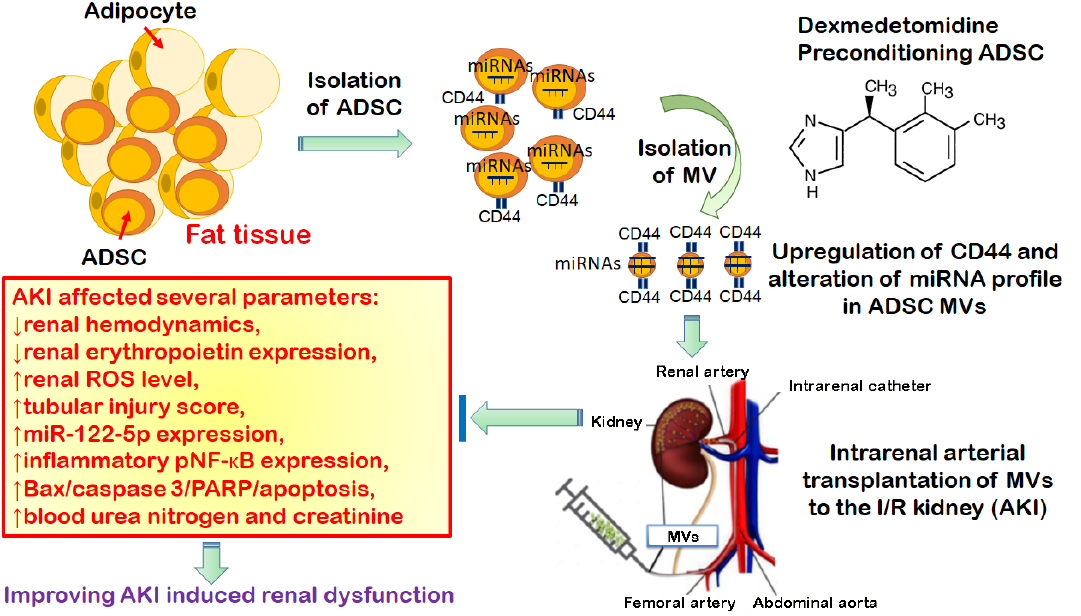
Figure 9. The summary diagram. The summary diagram suggests that DEX-preconditioned ADSC- derived MVs can provide CD44 homing effect; ameliorate IR-induced renal hemodynamics depres- sion; and reduce renal ROS level, tubular cell inflammation, apoptosis, tubular injury score, and renal dysfunction through downregulated miR-122-5p/Bax/PARP/apoptosis signaling and upregulated target-gene EPO expression in the post-IR kidney. DEX-preconditioned ADSC-derived MVs could be an important tool for utilization during renal IR injury. ADSC, adipose stem cells; AKI, acute kidney injury; DEX, dexmedetomidine; EPO, erythropoietin; MV, microvesicle; I/R, ischemia/reperfusion; PARP, poly-(ADP-ribose)-polymerase; ROS, reactive oxygen